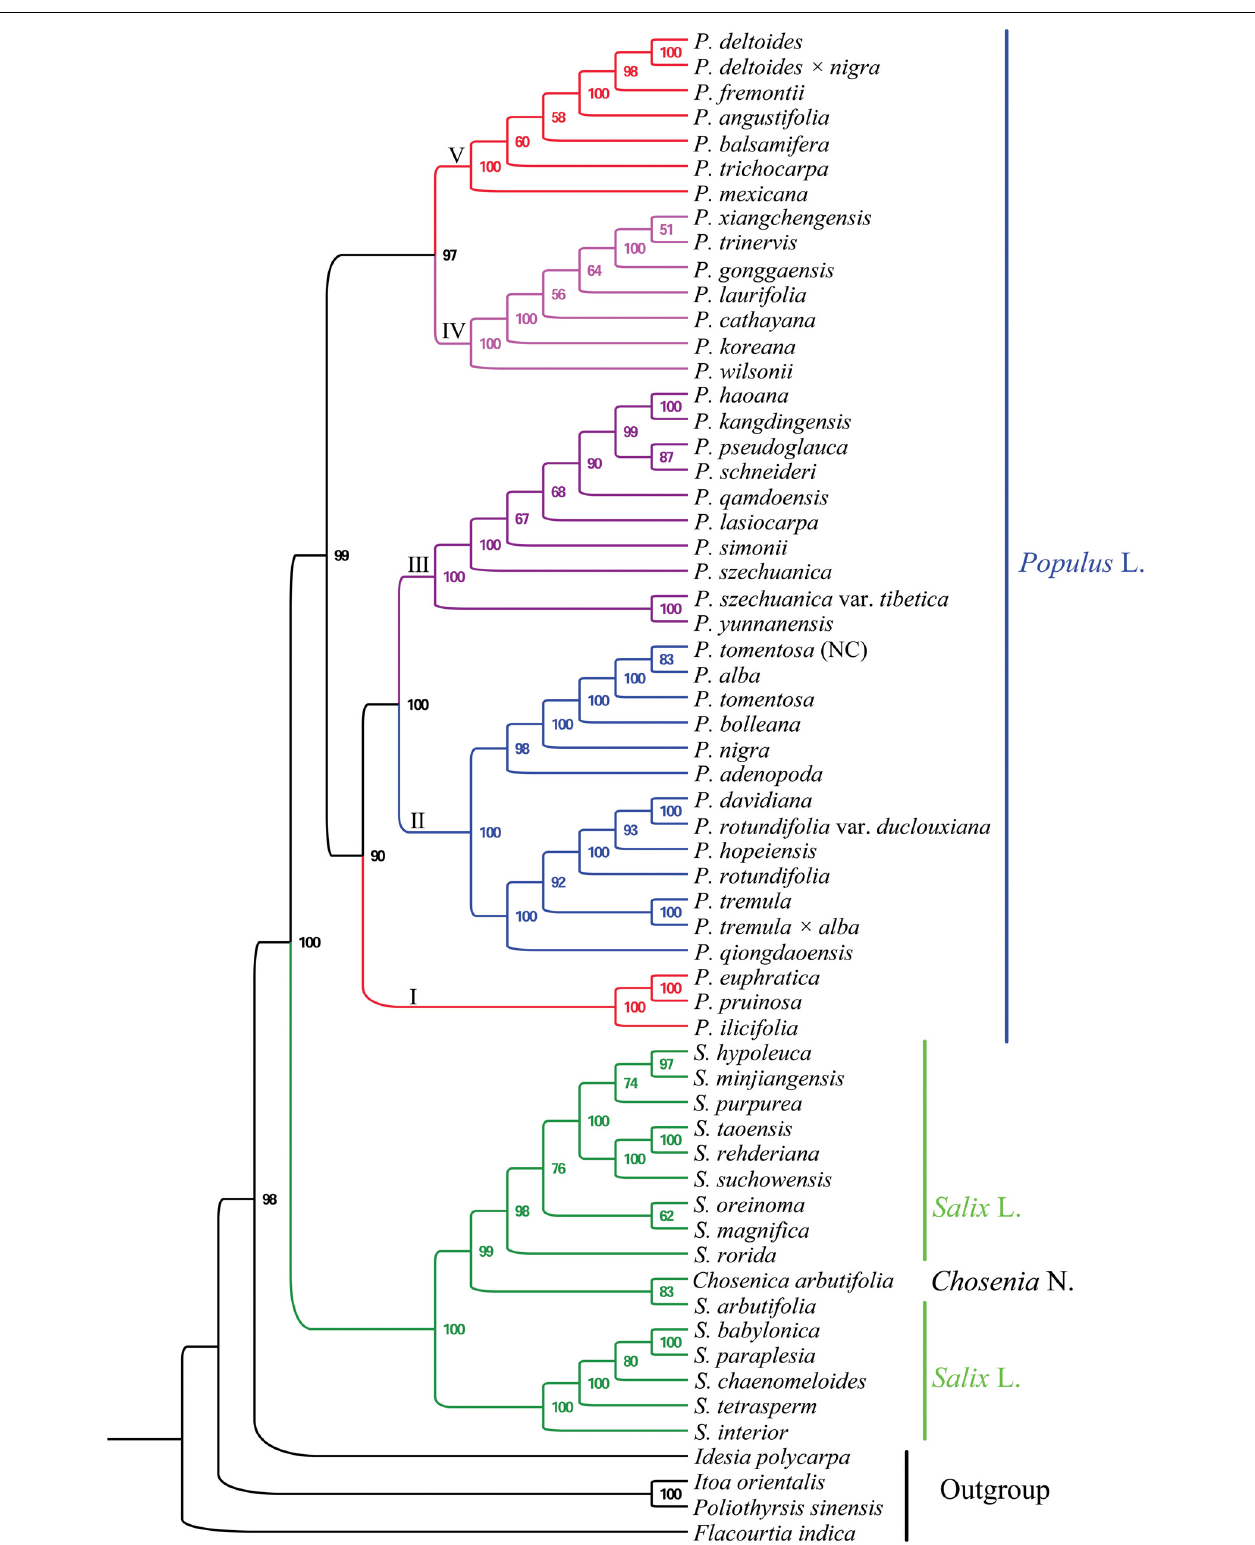
FIGURE 4 | Phylogenetic tree reconstructions of Populus using maximum likelihood (ML) based on whole chloroplast genome sequences.